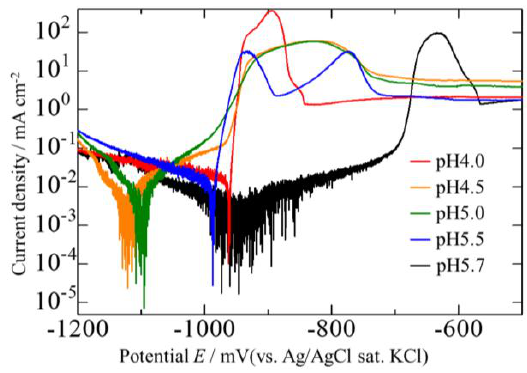
Figure 4. Anodic polarization curves of the Zn–Fe–Mo plating deposited at various pH values.